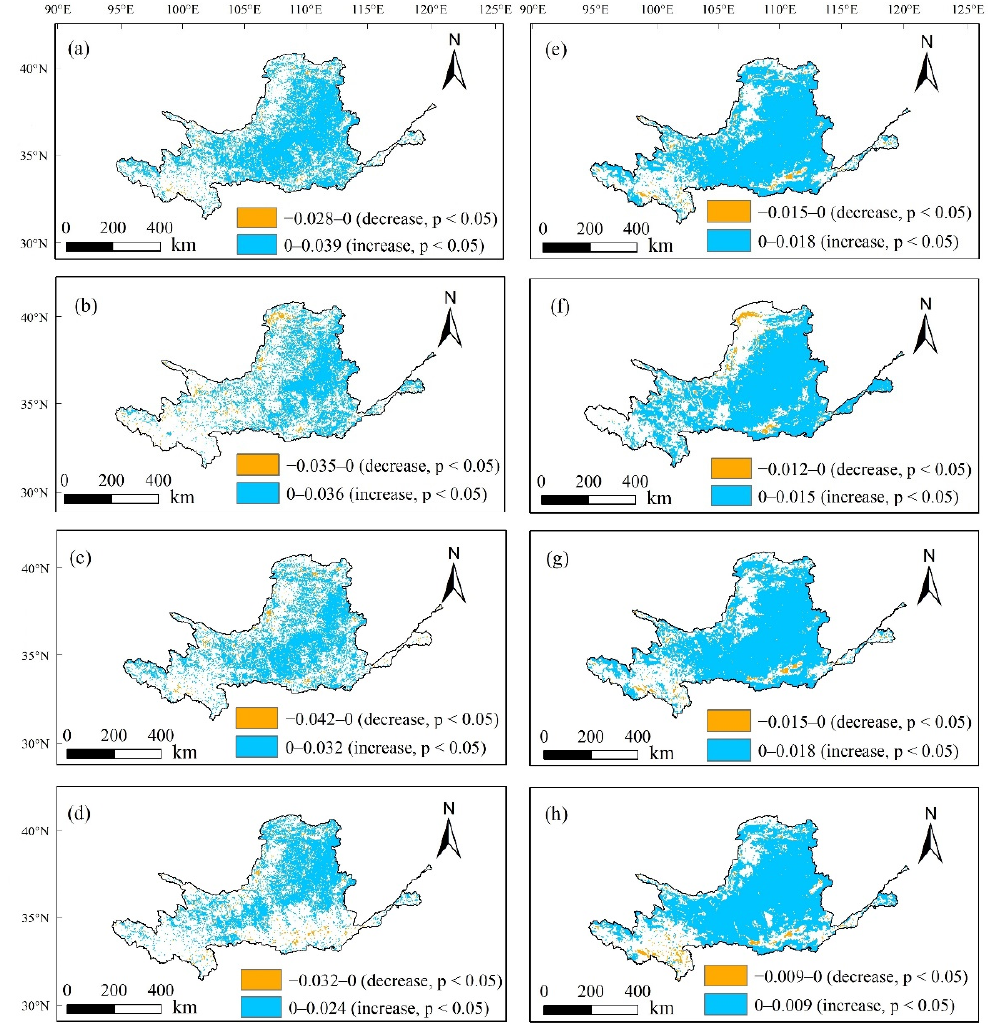
Figure 8. Significance test of seasonal vegetation ( a – h ). ( a ) Annual NDVI; ( b ) Spring NDVI; ( c ) Sum- mer NDVI; ( d ) Autumn NDVI; ( e ) Annual SIF; ( f ) Spring SIF; ( g ) Summer SIF; ( h ) Autumn SIF.